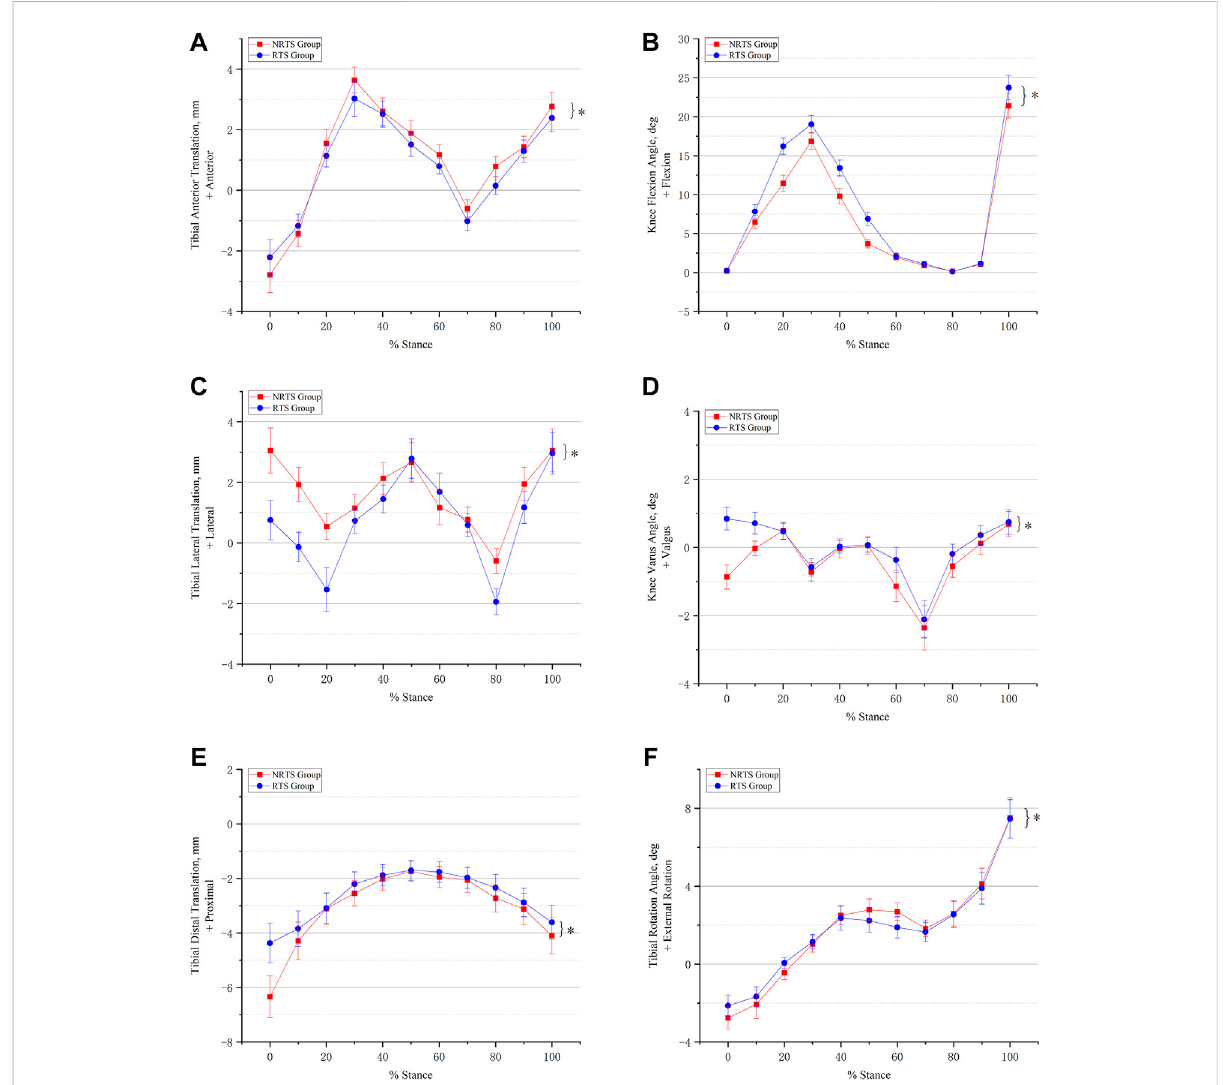
FIGURE 5 Comparison of six-degree-of-freedom knee kinematics during walking between those who passed the return-to-sports test and those who failed 9 months after ACL reconstruction. (A) Anterior-posterior translation. (B) Knee fl exion and extension. (C) Medial-lateral translation. (D) Varus- valgus movement. (E) Proximal-distal translation. (F) External-internal rotation.*Signi fi cant difference betweengroups. NRTS, not return-to-sports; RTS,